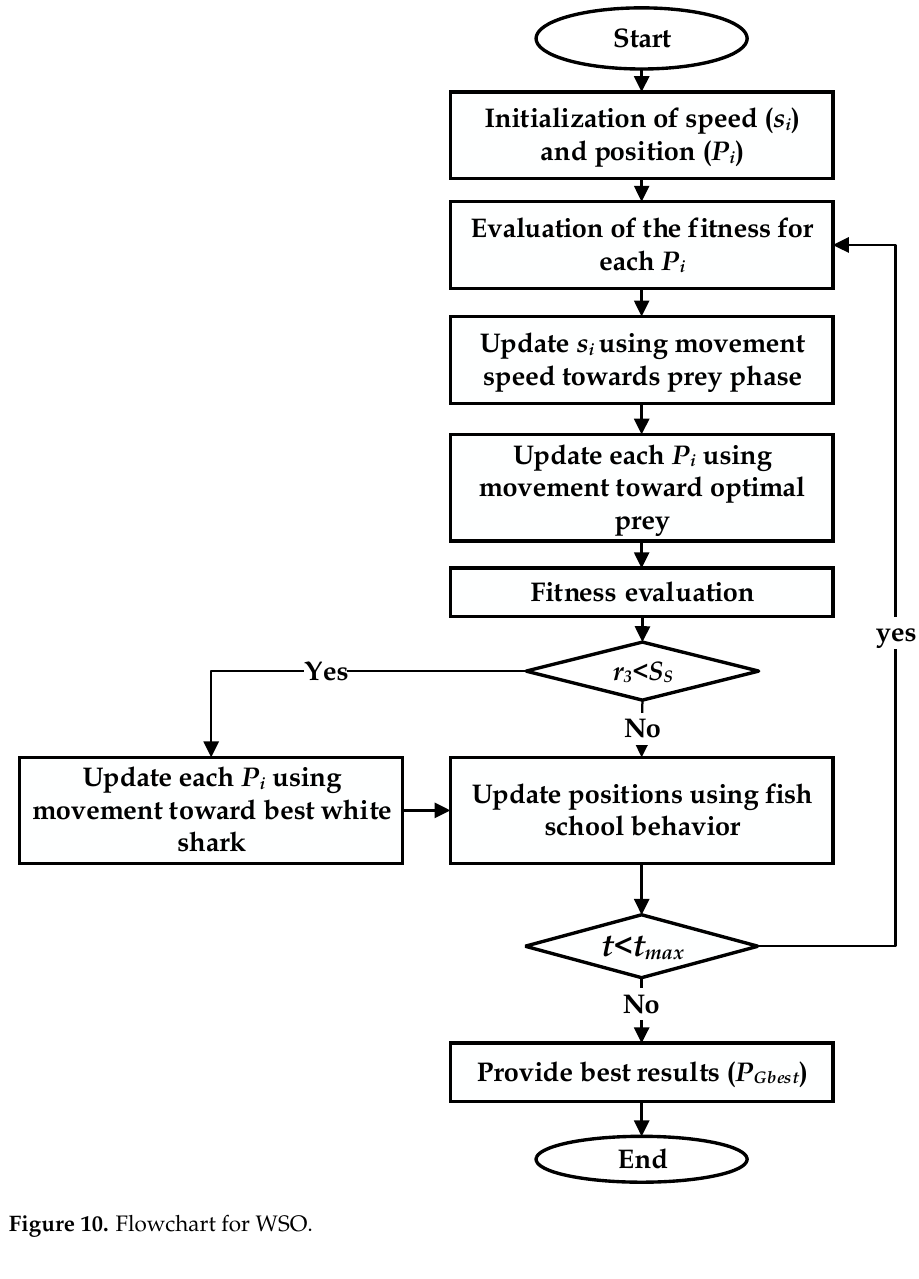
Figure 10. Flowchart for WSO.